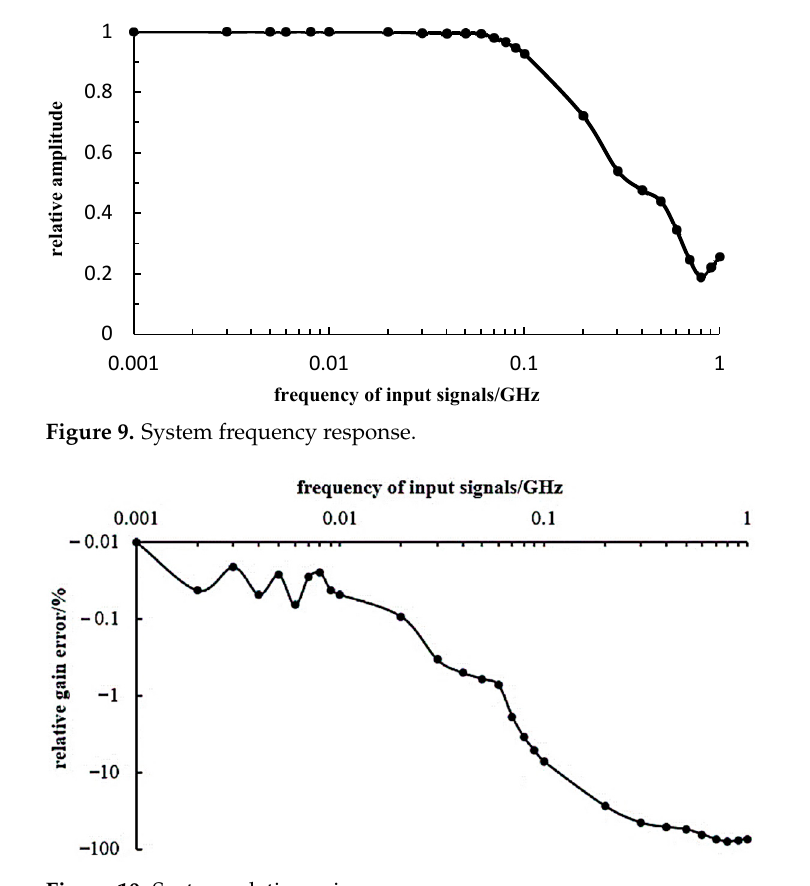
Figure 10. System relative gain error.